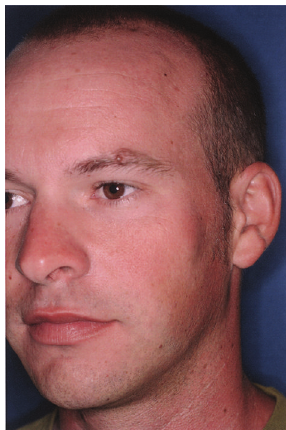
Figure 2: Left zygomatic arch expansion.